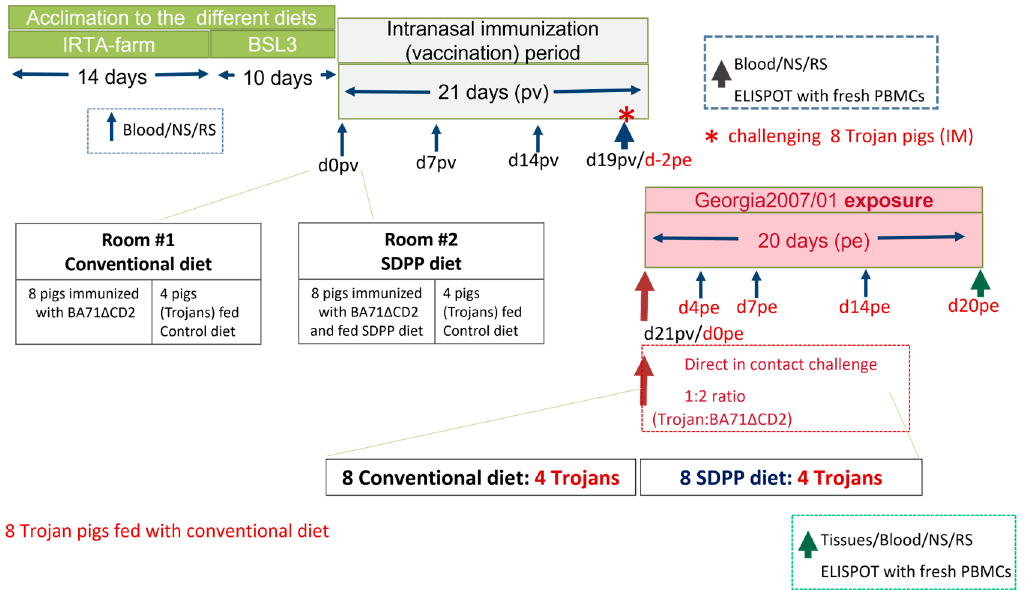
Figure 1. Schematic representation of the study design. Abbreviations: BSL3 = biosafety level 3; NS = Nasal swab; RS= rectal swab; pv = post-vaccination; pe = post-exposure; d = day; PBMCs = peripheral blood mononuclear cells.